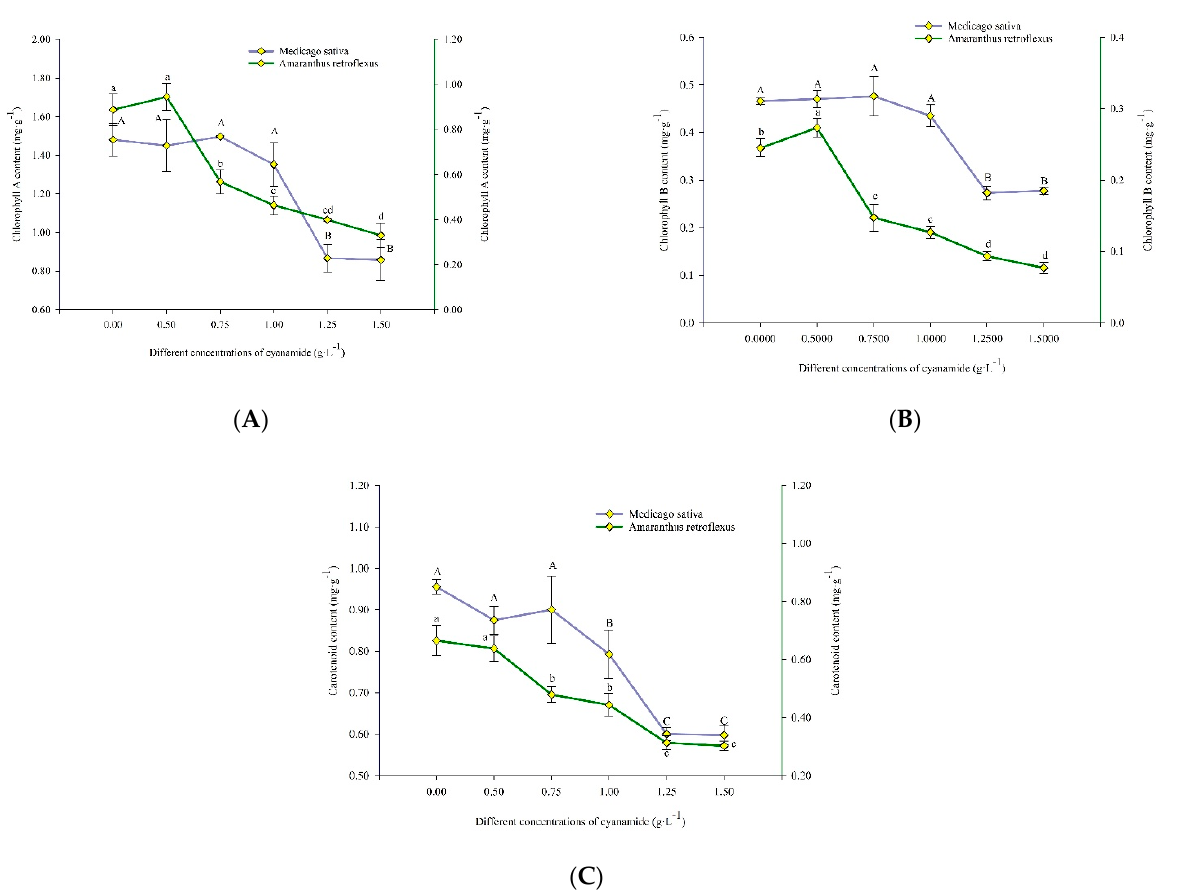
Figure 6. The content of chlorophyll A, chlorophyll B and carotenoids in alfalfa and amaranth ex- posed to CA. ( A ) The content of chlorophyll A in alfalfa and amaranth exposed to CA. ( B ) The con- tent of chlorophyll B in alfalfa and amaranth exposed to CA. ( C ) The content of carotenoids in alfalfa and amaranth exposed to CA. Different letters in columns indicate significant differences among treatments at p < 0.05 (LSD test).